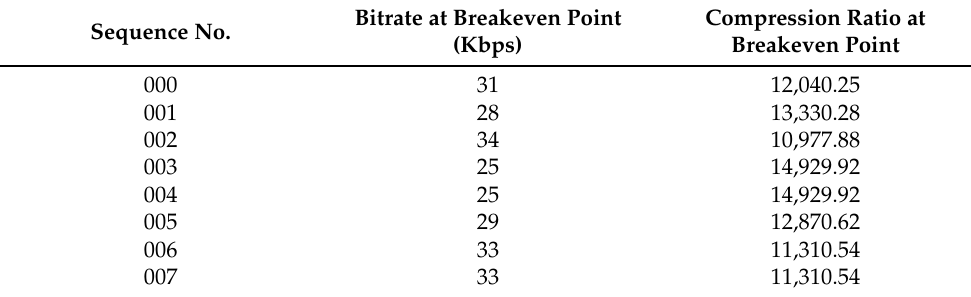
Table 1. Compression ratio at breakeven point of each video sequence.